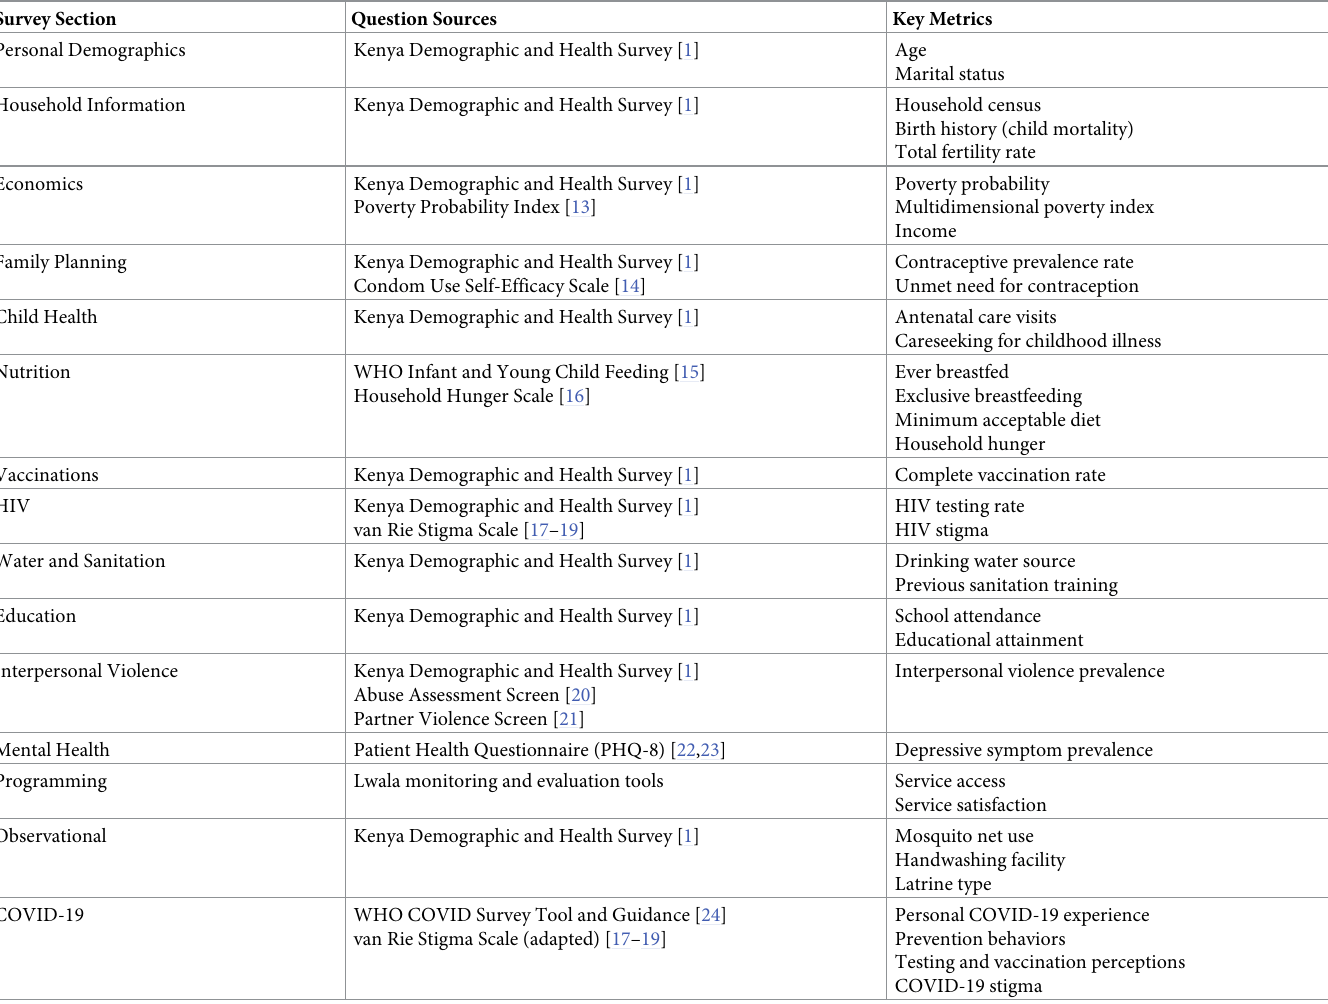
Table 3. Survey modules, key metrics, and sample